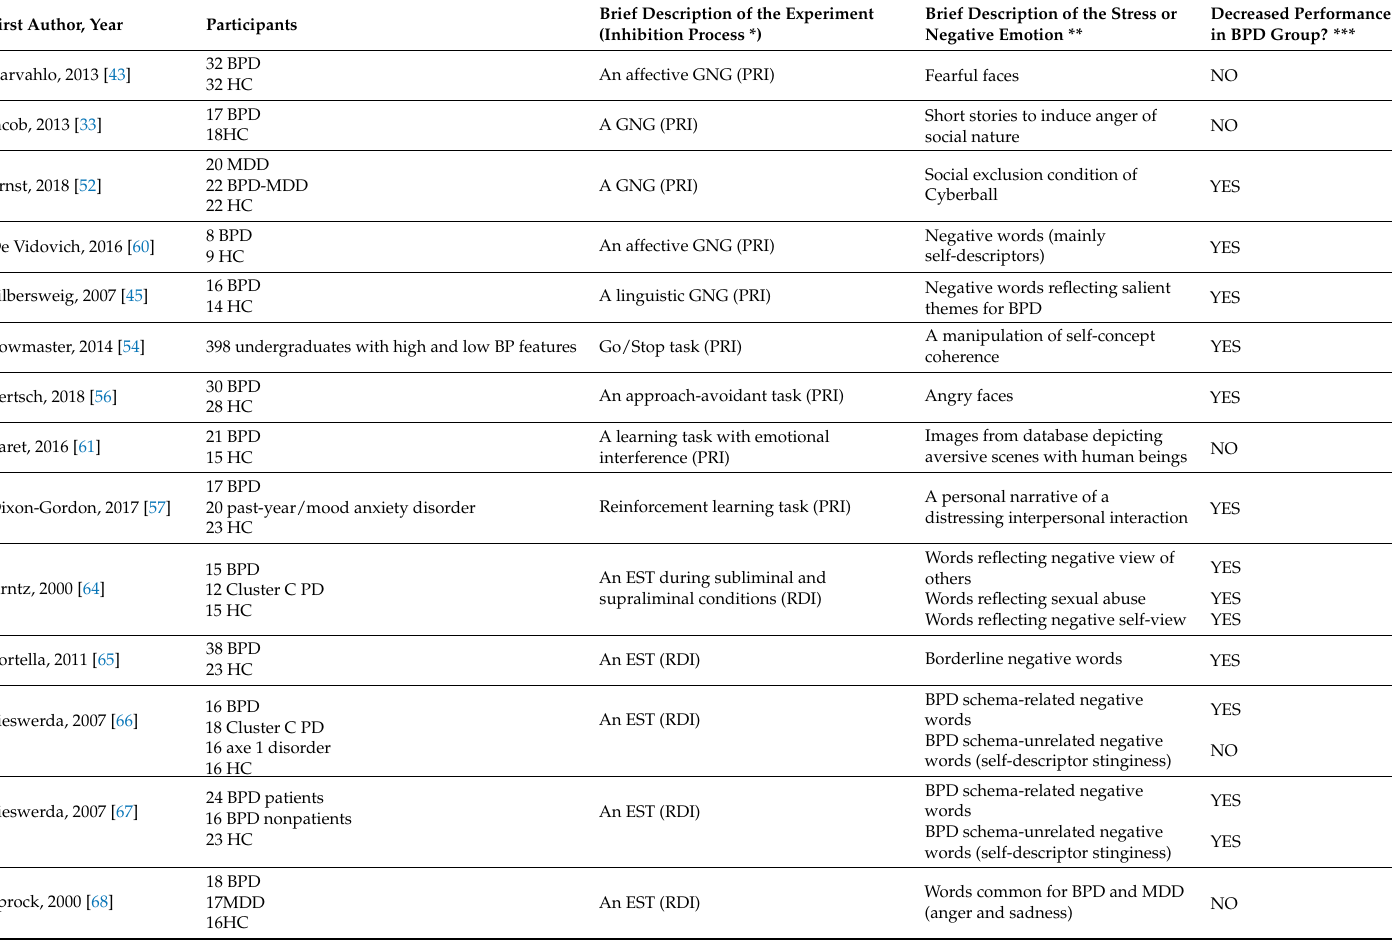
Table 1. Results of 19 studies with self-reference processes during the emotional or stressful